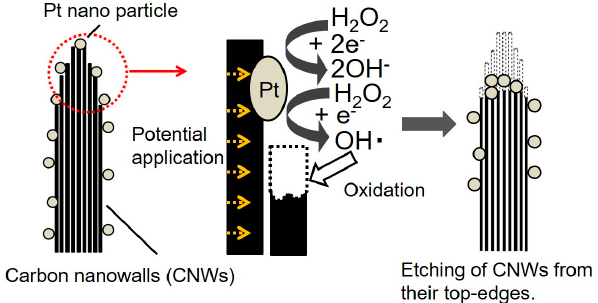
Figure 6. Illustration of degradation model of Pt-CNWs via secondary reaction with byproducts of H 2 O 2 reduction.